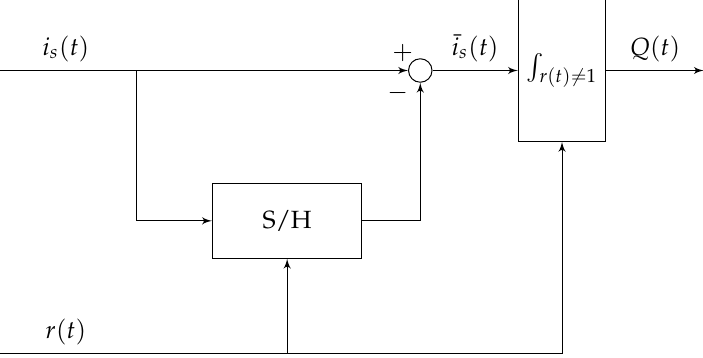
Figure 8. Electronic circuitry implementing the IDIM technique, adopted from [27].